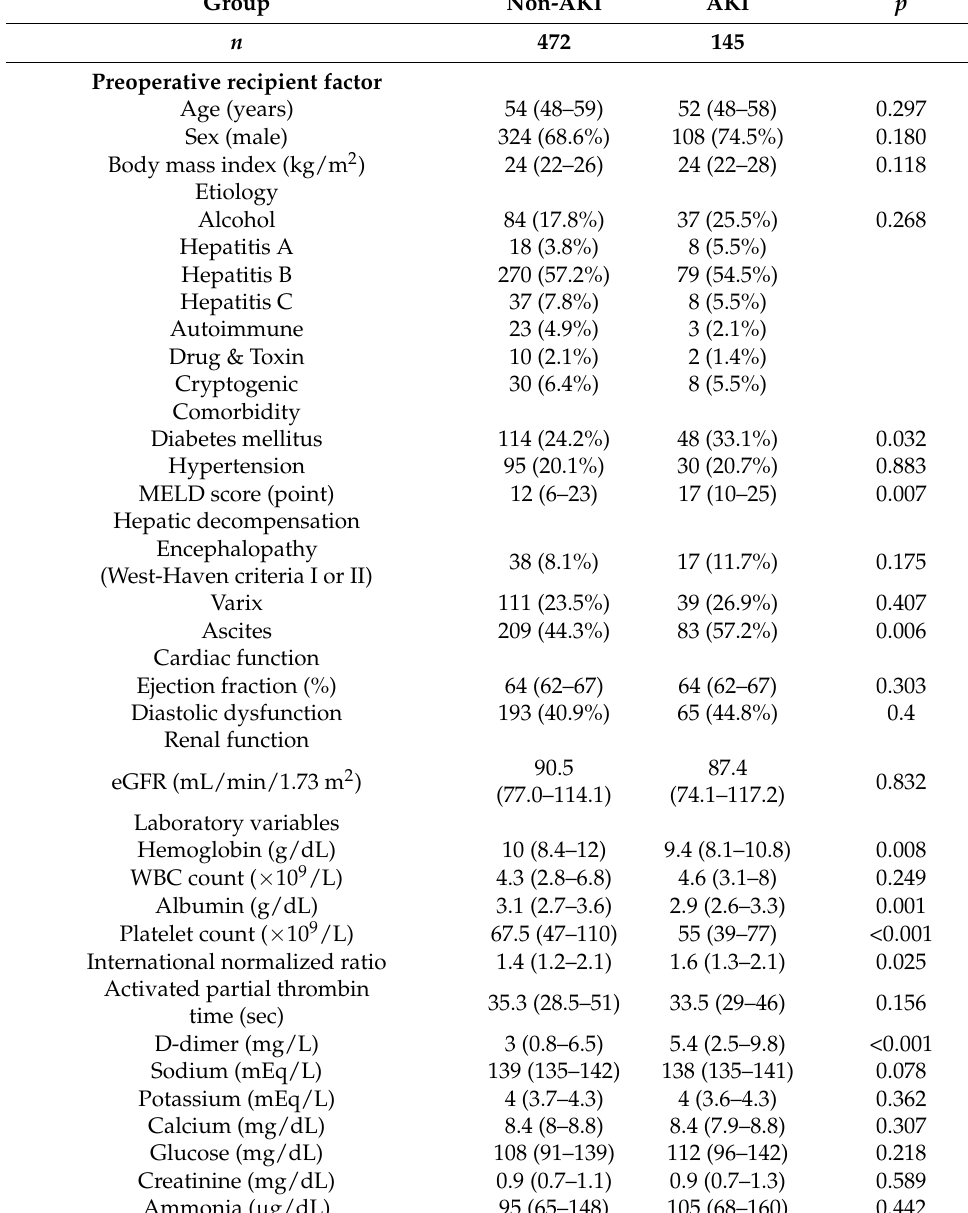
Table 1. Comparison of preoperative recipient clinical factors between the non-AKI and AKI